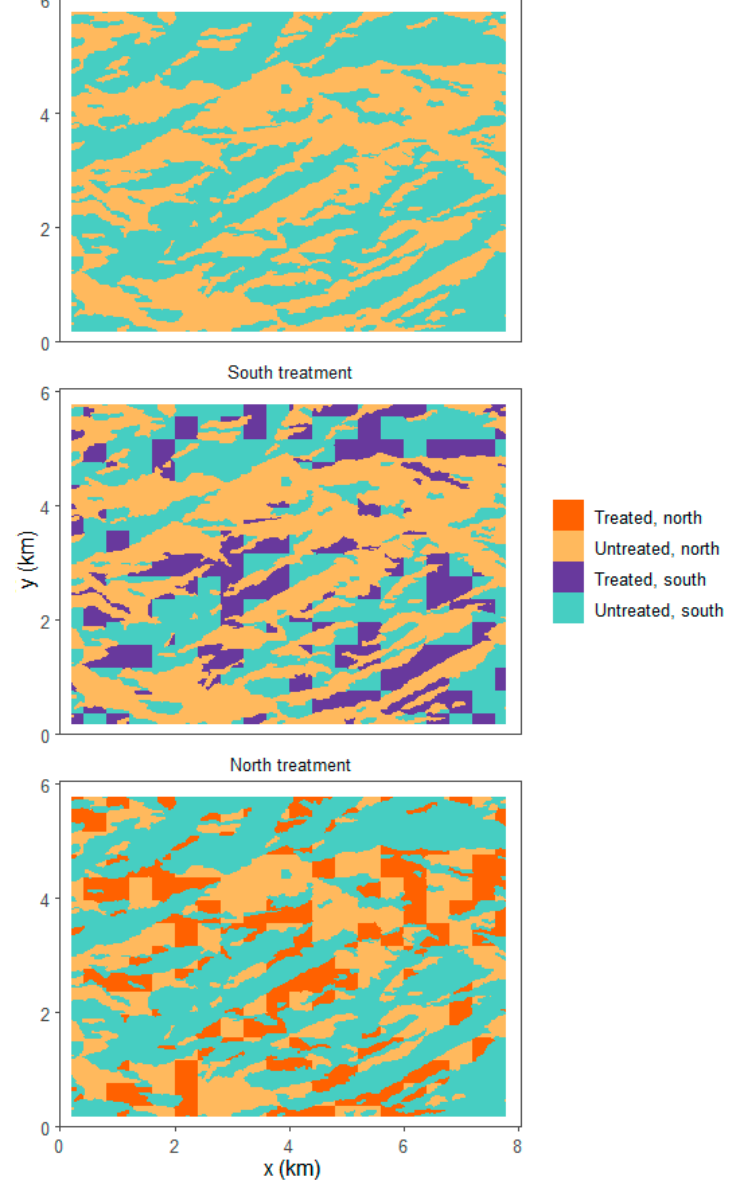
Figure 2. Aspect delineation and location of treatments for each of the three scenarios.